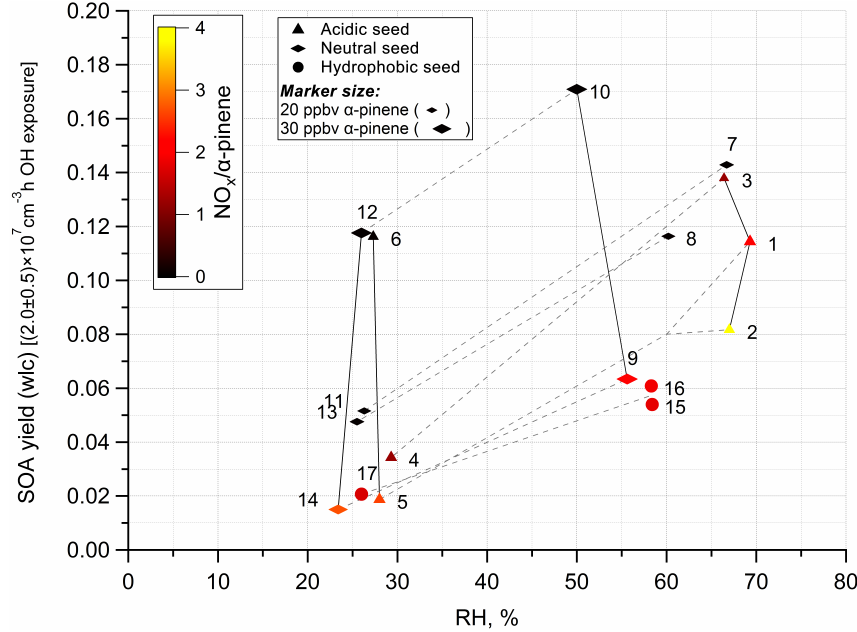
Figure 2. Average wall-loss-corrected yields Y at (2.0 ± 0.5) × 10 7 cm − 3 h OH exposure as a function of RH. Symbol sizes represent α - pinene reacted, symbol colours represent NO x /α -pinene and symbol shapes represent seed composition according to Table 1. Experiments with similar NO x /α -pinene, seed composition and α -pinene reacted are connected with dashed lines showing the increase in yield for increased RH. Experiment 6 has no counterpart experiment at high RH. Experiments with similar RH, α -pinene reacted and seed composition are connected with solid lines showing the increased yield with a decreasing NO x /α -pinene